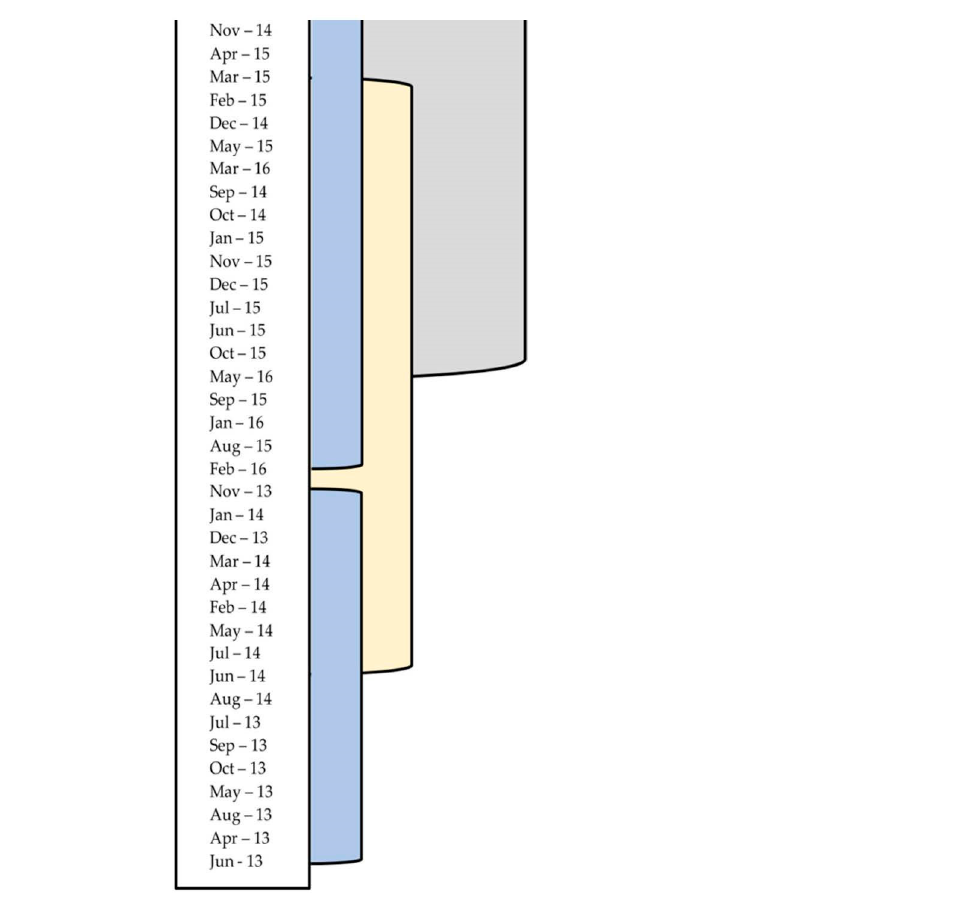
Figure 5. Financial indexes dendrogram using average linkage (between groups).